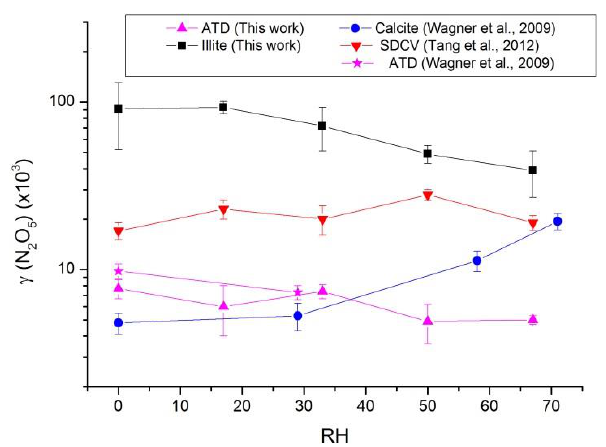
Fig. 7. Comparison of relative humidity dependence of N 2 O 5 up- Figure 7. Comparison of relative humidity dependence of N take coefficients to airborne mineral dust coefficients to airborne mineral dust particles.